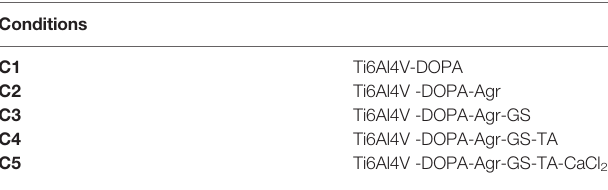
TABLE 2 | Different coating conditions of Ti6Al4V